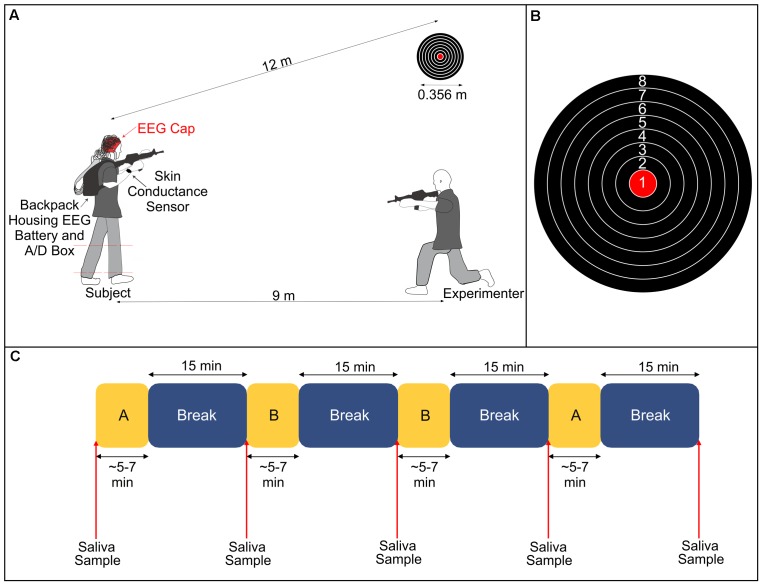
(A) Illustration of experimental setup. The subject fired an airsoft rifle at a stationary target 12 m away during all conditions. During the Stress condition, an experimenter, positioned 9 m away and at a 30° angle from the target, fired a different airsoft rifle at the subject’s lower legs (dashed red lines denote the region that the subject was hit). (B) Diagram of the target and the numerical value associated with each gradation. (C) Breakdown of the experimental protocol. Subjects completed two blocks of each condition (A and B, representing either Stress or Control), with each block followed by a 15-min rest period. We took saliva samples immediately before starting the experiment and at the conclusion of each break. The lengths of A and B varied depending on the subjects’ self-selected paces.